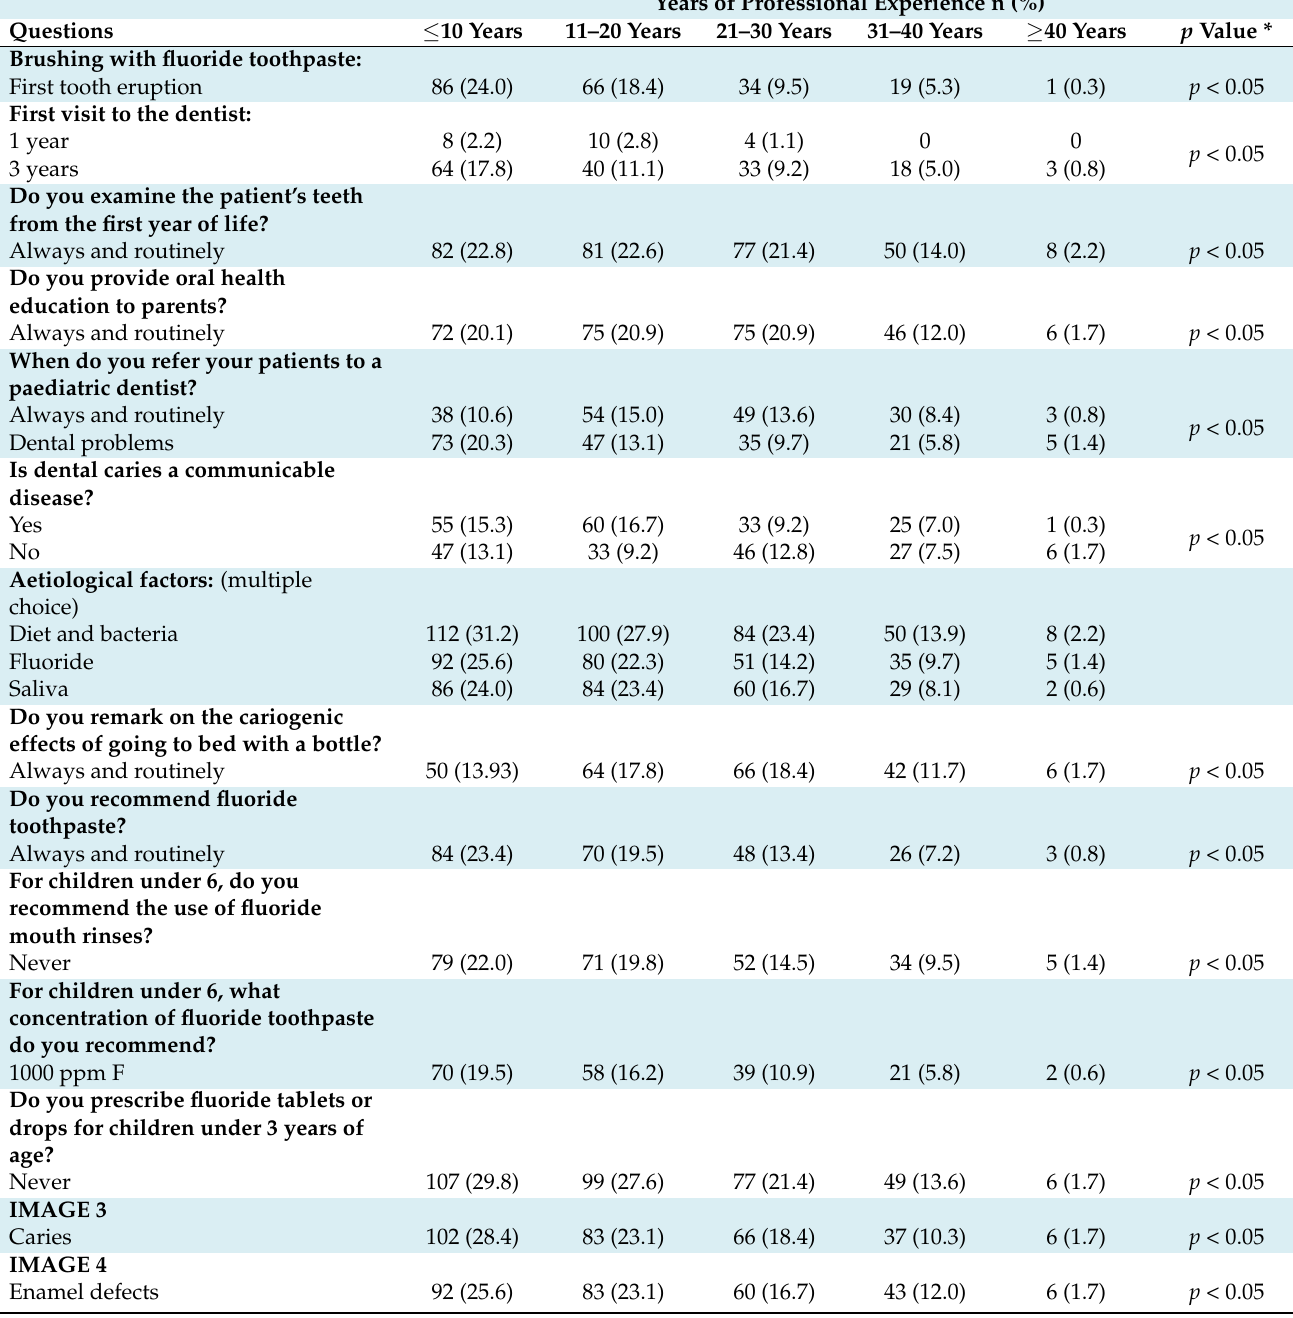
Table 6. Knowledge of primary dentition, oral health and early childhood caries and lesion identifica- tion according to years of experience of the study